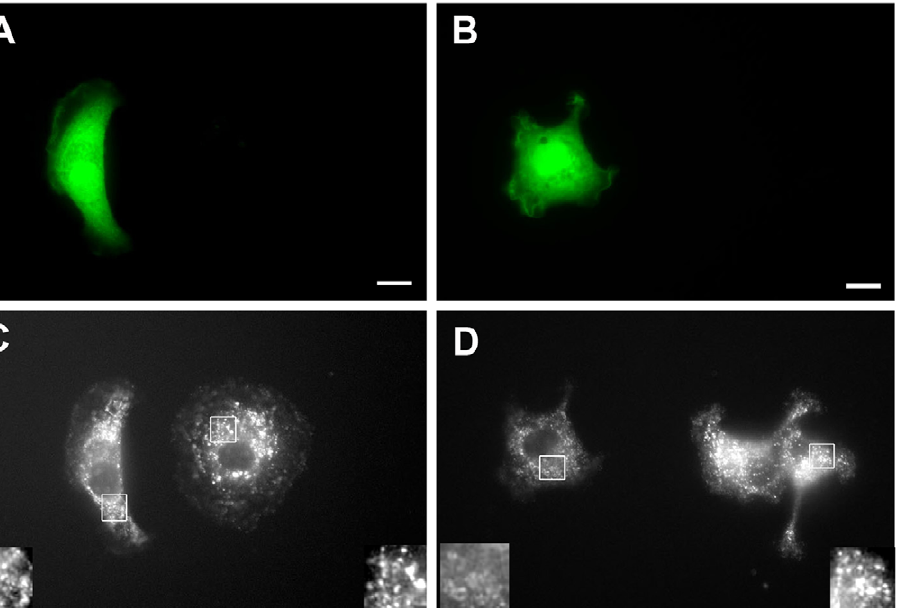
Figure 8. Kermit2 regulates internalization of antibody bound a 5 b 1 integrin. Xenopus A6 cells were transfected with (A) GFP-tagged kermit2, or (B) GFP-tagged kermit2 mut and the endocytosis of antibody labeled a 5 b 1 was estimated from fluorescent intensity using the density slice function of Openlab. (C, D) Staining of internalized a 5 b 1 with fluorescent anti-mouse antibody. Non-transfected cells in the same dish act as controls. Insets in C and D represent 25 m M 2 ROI’s used to estimate pixel densities. (A, C) Kermit2 transfected cells have 827.3 6 23.0 pixels/ROI as compared to control cell ROI pixel densities of 841.5 6 13.3 pixels/ROI. (B, D) In kermit2 mut transfected cells the ROI pixel density is 530.8 6 51.2, while in non- transfected cells from the same dish have an average pixel density of 832.5 6 24.3 pixels/ROI. Pixel densities represent averages ( 6 SD) from 10 individual cells from 4 separate transfections. Size marker =25 m M.